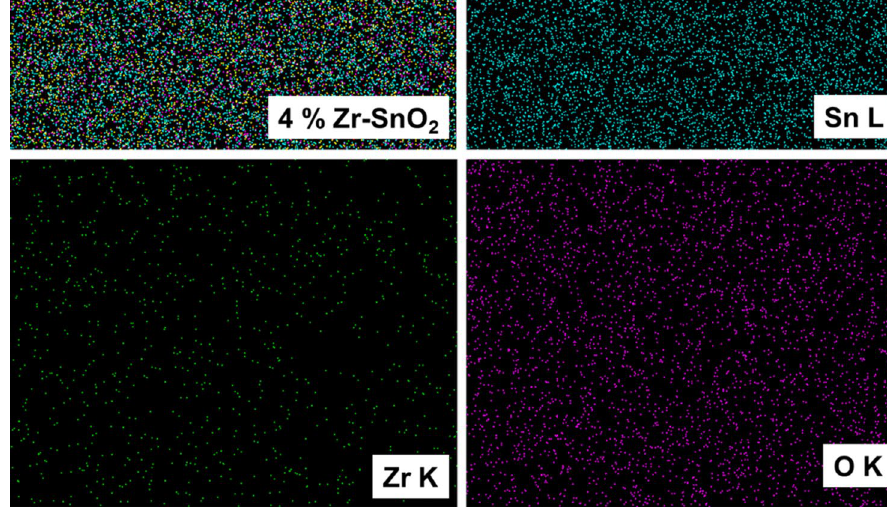
Fig. 5 A UV spectra and B bandgap energy of (a) SnO 2 , (b) 2% Zr-doped SnO 2 NPs and (c) 4% Zr-doped SnO 2